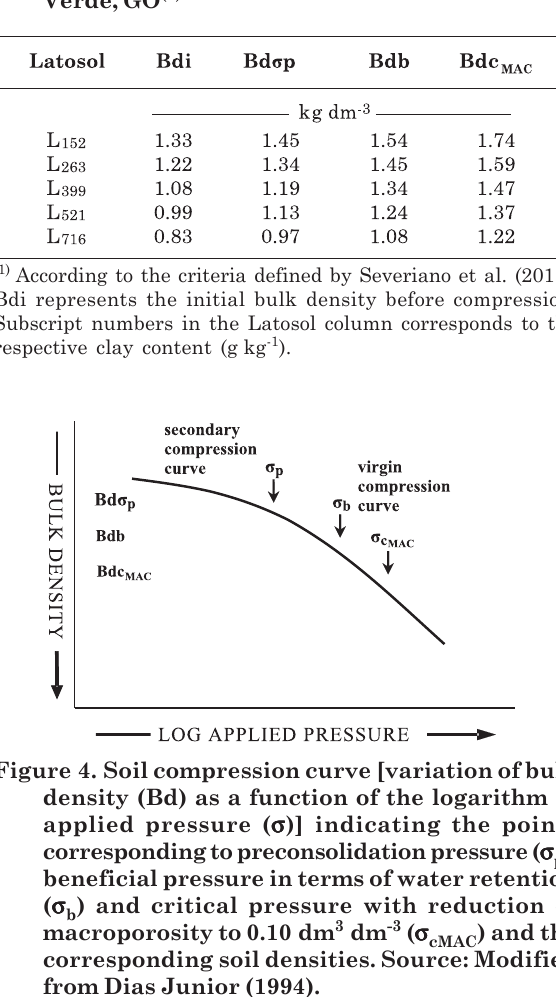
Table 1. Initial bulk density (Bdi) and bulk density at preconsolidation pressure (Bd σσσσσ p) corresponding to beneficial compaction in terms of water retention (Bdb) and the reduction of macroporosity to 0.10 dm 3 dm -3